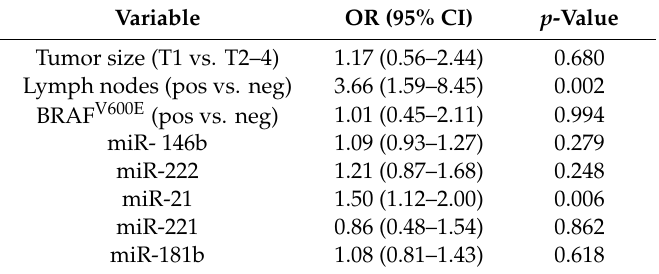
Table 2. Multivariate analysis of associations of PTC recurrence with prognostic factors. Binary logistic regression model was used. Odds ratios adjusted by gender and age categories ( < 45 years vs. ≥ 45 years). Table 3. Univariate and multivariate analysis of disease-free survival (DFS) in patients with PTC. Cox proportional regression hazard model was used.